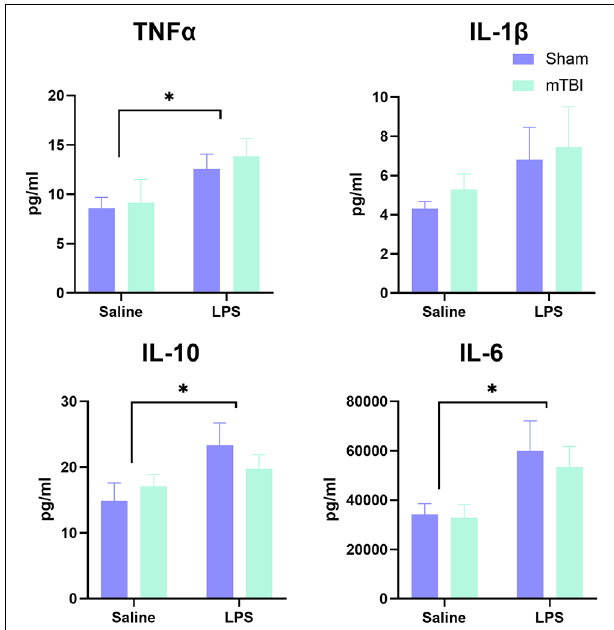
FIGURE 1 | Analysis of peripheral cytokine expression at 4 h post-LPS administration in a subset of animals ( n = 5 per group). A significant effect of LPS administration was found for IL-6, TNF, and IL-10, but not IL-1 β , with no difference between injured and sham animals in response to LPS. ∗ p < 0.05, saline vs. LPS